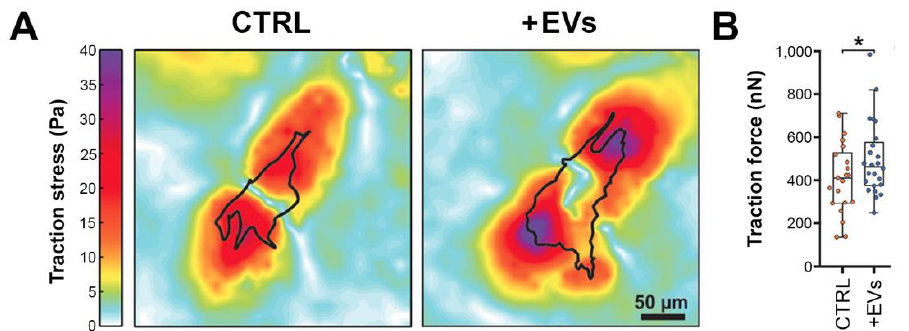
Figure 6. Increased contractility of stellate cells after the internalization of UM-derived EVs. HSteCs were grown on 5 kPa polyacrylamide gels containing fluorescent beads and exposed for 24 h to large EVs from metastatic UM cells TJU-UM001. Then, bead displacements between stressed (+EVs) and null (CTRL) states were measured using TFM. ( A ) Representative traction stress maps (Pa) and ( B ) traction force (nN) are shown for untreated (CTRL) or treated (+EVs) HSteCs. Scale bar, 50 µm. Plots are median ± the minimum and maximum values. * p < 0.05 (Welch’s t -test).